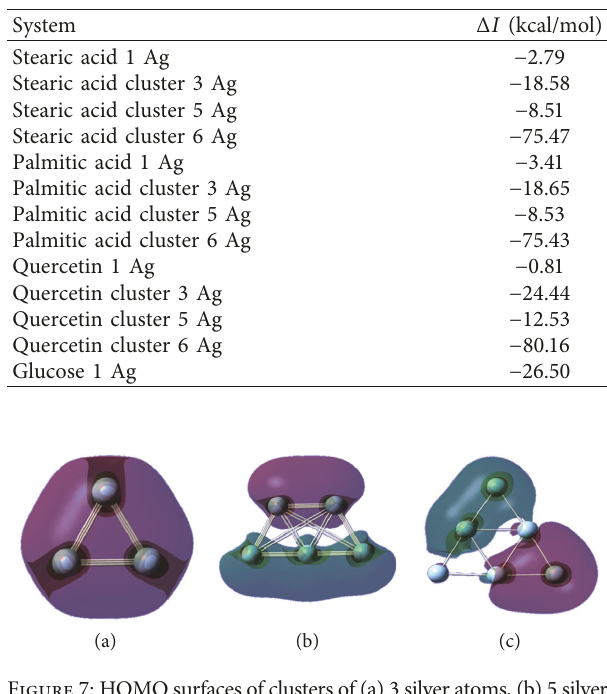
Table 1: Interaction energies between the clusters of 1, 3, 5, and 6 atoms of silver, stearic acid, palmitic acid, and quercetin.